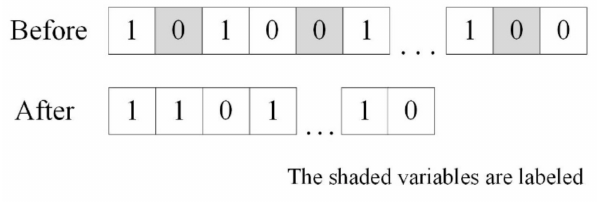
Figure 3. Clipping of the chromosome of the topology